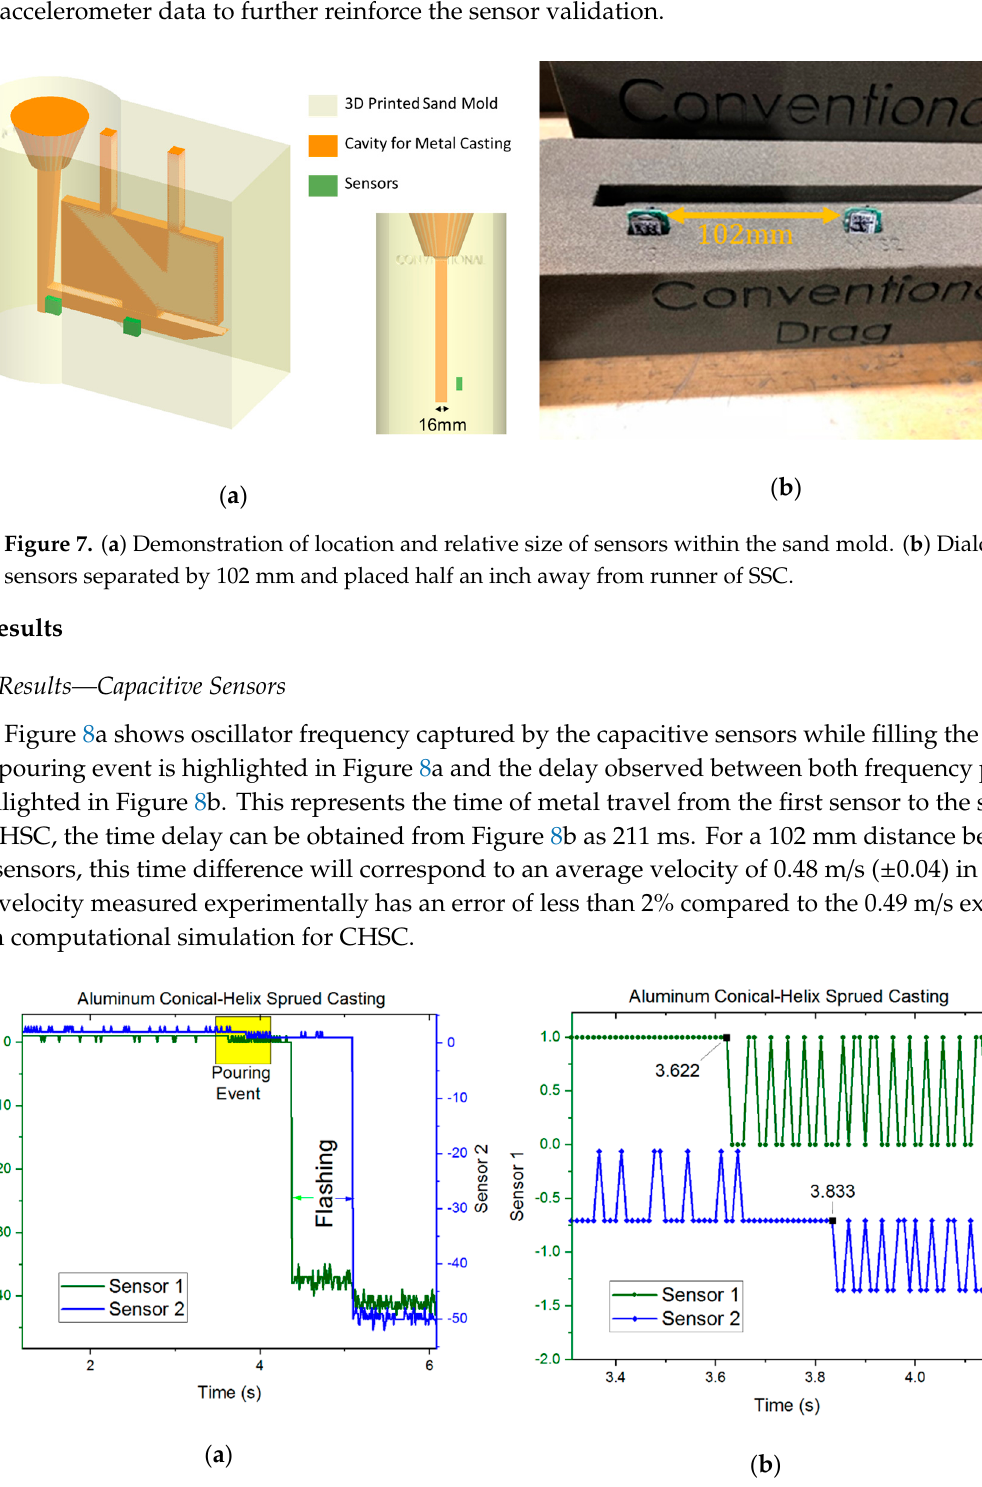
Figure 8. ( a ) Oscillator frequency recorded by the capacitive sensors during the CHSC pouring event. ( b ) Oscillator frequency during the pouring event.